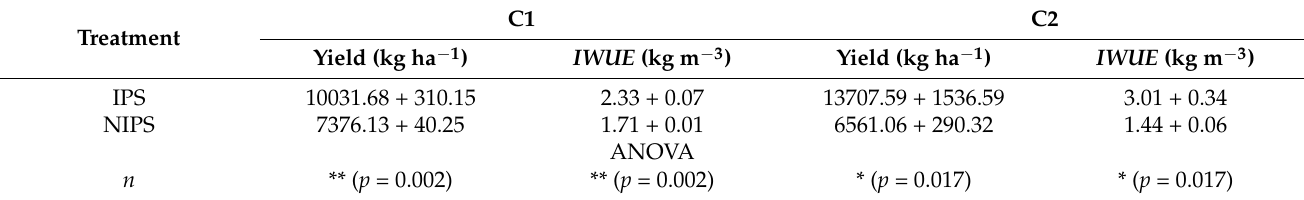
Table 2. Effect of IPS on yield and IWUE of